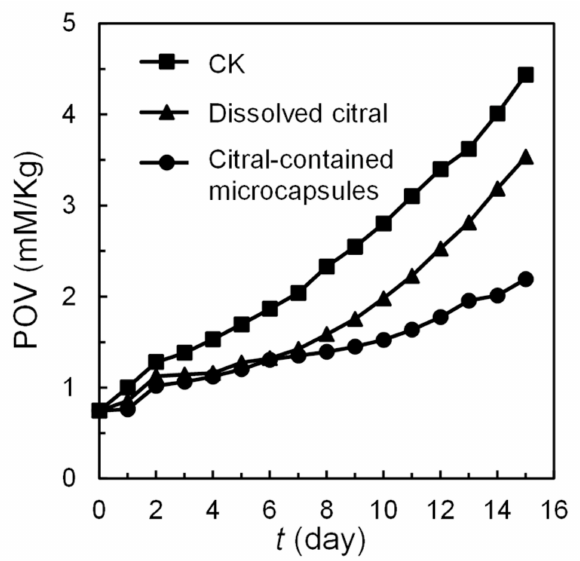
Figure 9. The peroxide values (POVs) of soybean oil with citral-containing alginate microcapsules, dissolved citral and without